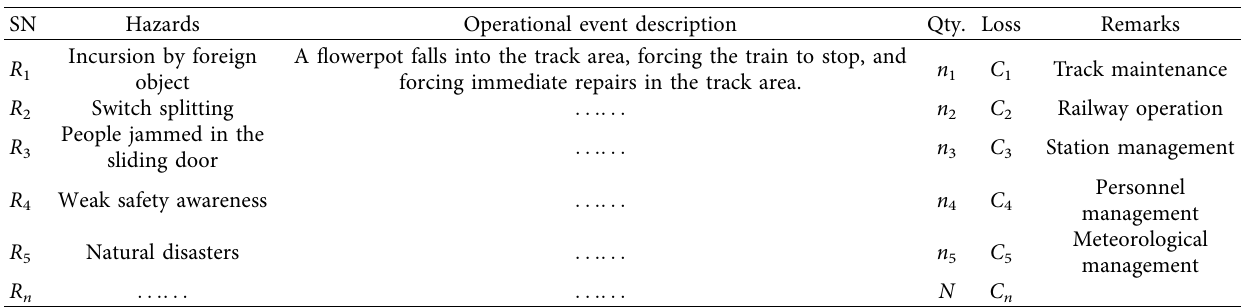
Table 2: Risk big data lake.